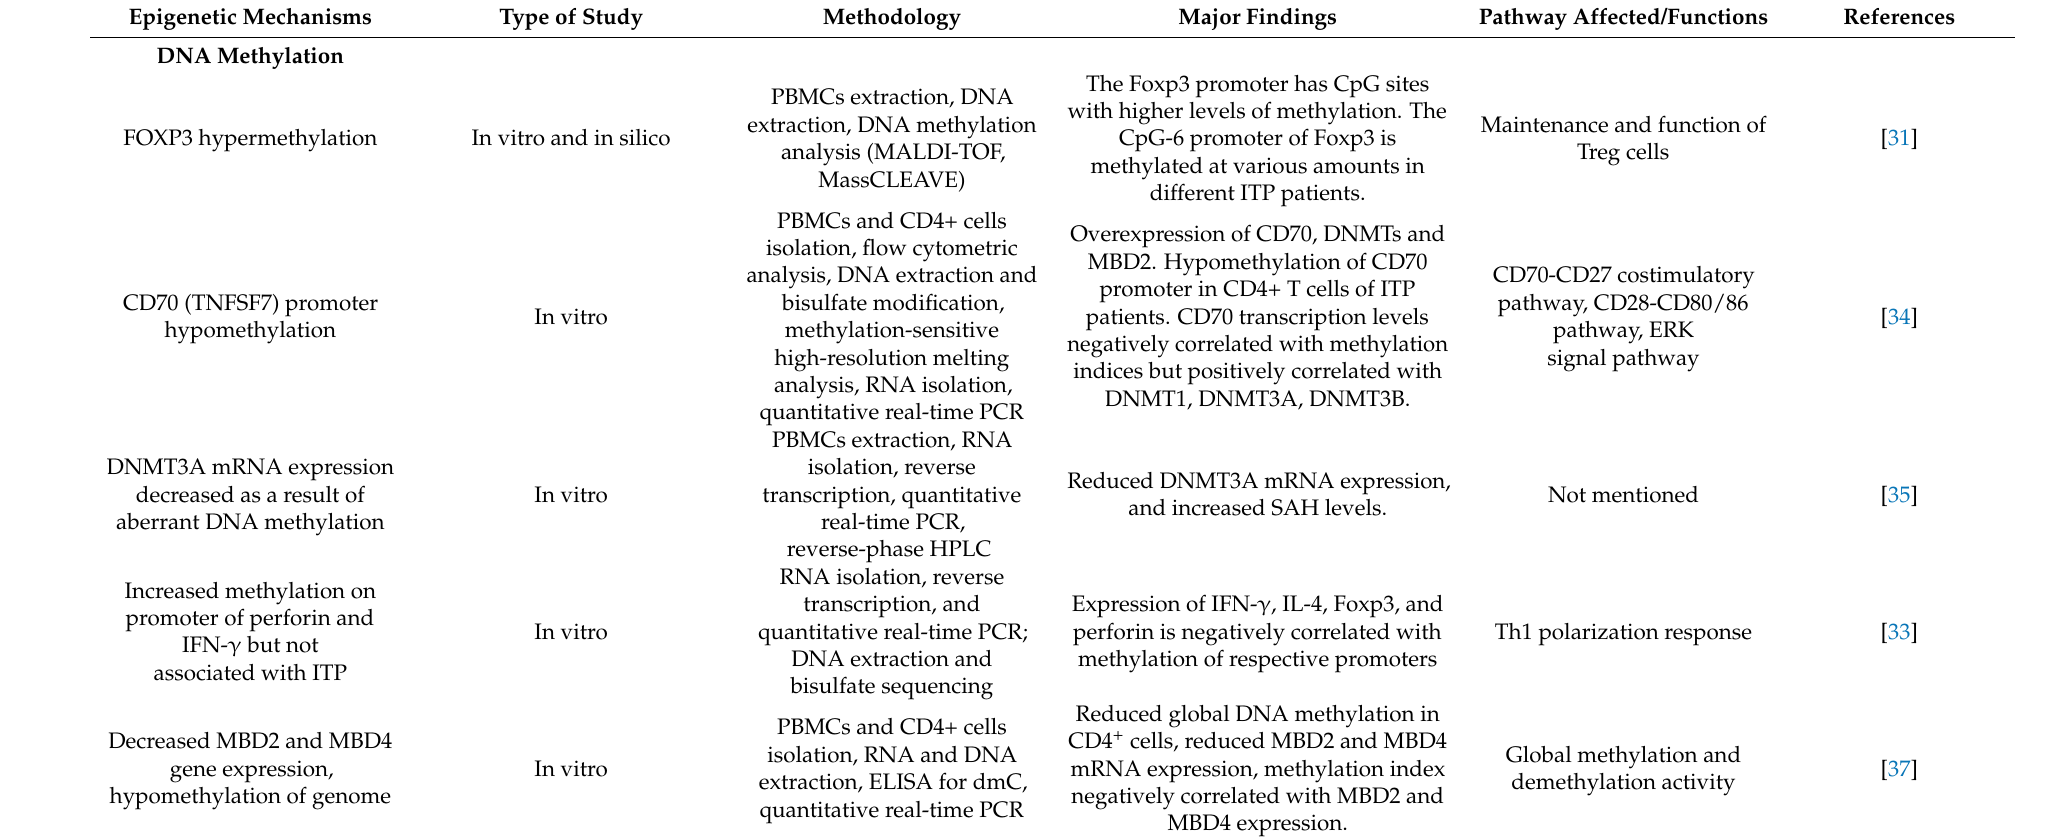
Table 1. Studies on epigenetic mechanism in immune thrombocytopenia purpura